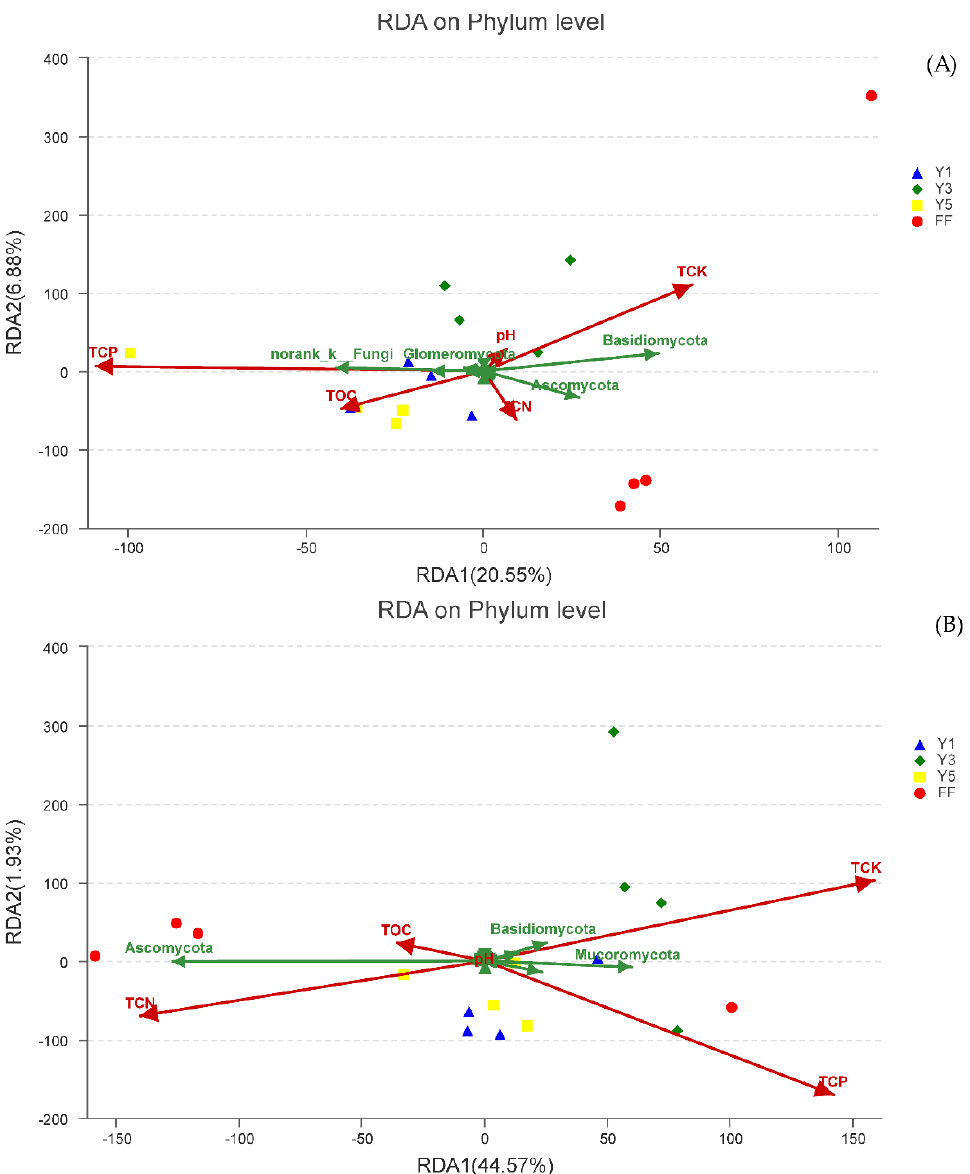
Figure 7. The length and angle of lines represent redundancy analysis (RDA) of the abundant fungal phyla and environmental variables in winter ( A ) and summer ( B ); Correlations between RDA axes and the environmental variables. Correlations between RDA axes and the rhizosphere fungal phyla are represented by words (i.e., the fungal phylum names). FF: fallow field soil; Y1: one ‐ year C. chinensis cultivated soil; Y3: three ‐ year C. chinensis cultivated soil; Y5: five ‐ year C. chinensis cultivated soil; TCN: total content of Nitrogen; TCP: total content of phosphorus; TCK: total content of potassium; TOC: total organic carbon and pH.